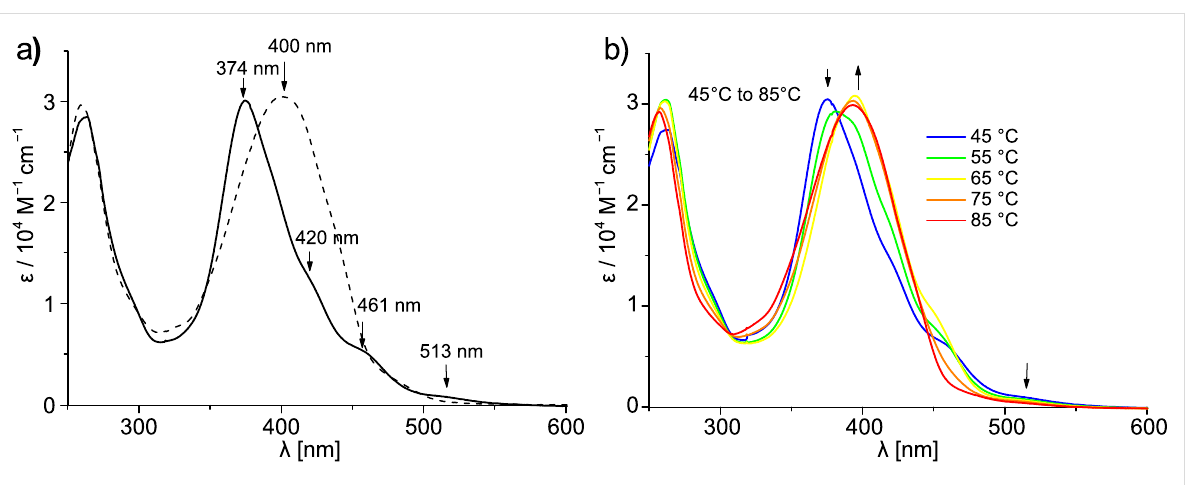
Figure 2: a) UV-vis spectra of T1 in chloroform (dashed line) and n -heptane (solid line); b) UV-vis spectra of T1 in n -heptane at different tempera- tures. Concentration of T1 is 5 x 10 − 5